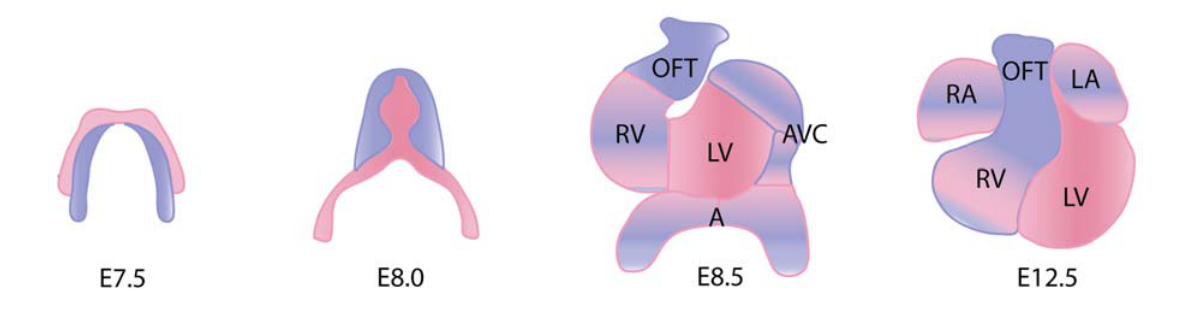
FIGURE 1. Morphology of the developing heart and the two sources of myocardial cells. Vertebrate cardiac morphogenesis begins shortly after gastrulation when the primary (classical) heart field progenitors are specified in the anterior, lateral mesoderm forming the cardiac crescent (pink) at E7.5. The second cardiac lineage (blue) is located in the splanchnic mesoderm, medially and dorsally compared to the primary heart field. As the embryo folds, the primary heart field progenitors then migrate and fuse at the ventral midline of the embryo, forming the muscular linear heart tube at E8.0. At this stage, the second lineage precursors become located in a more dorsal and anterior position. Between E8.25 and E10.5, the linear heart tube undergoes rightward looping and the second lineage precursors migrate into the heart, contributing to both the arterial and venous poles of the developing heart. Retrospective clonal analysis suggests that all regions of the heart tube are colonized by both sources of cardiac progenitors with the exceptions of the left ventricle, which is derived entirely from the primary heart field, and the outflow tract, which is formed exclusively from the second lineage. Following cardiac looping, the heart enters the remodeling phase during which the cardiac chambers mature and septate, forming the four-chambered organ shown here at E12.5. LA, left atrium; LV, left ventricle; RA, right atrium; RV, right ventricle; OFT, outflow tract; A, atria. Modified from Kelly et al.[9], ©2001 with permission from Elsevier and from Buckingham et al.[4], ©2005 with permission from Nature Publishing